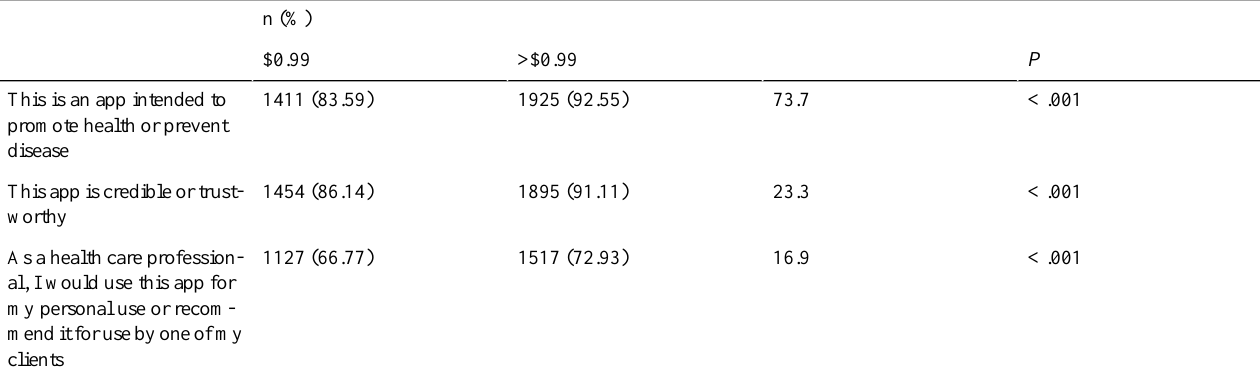
Table 1. Comparison of app credibility by